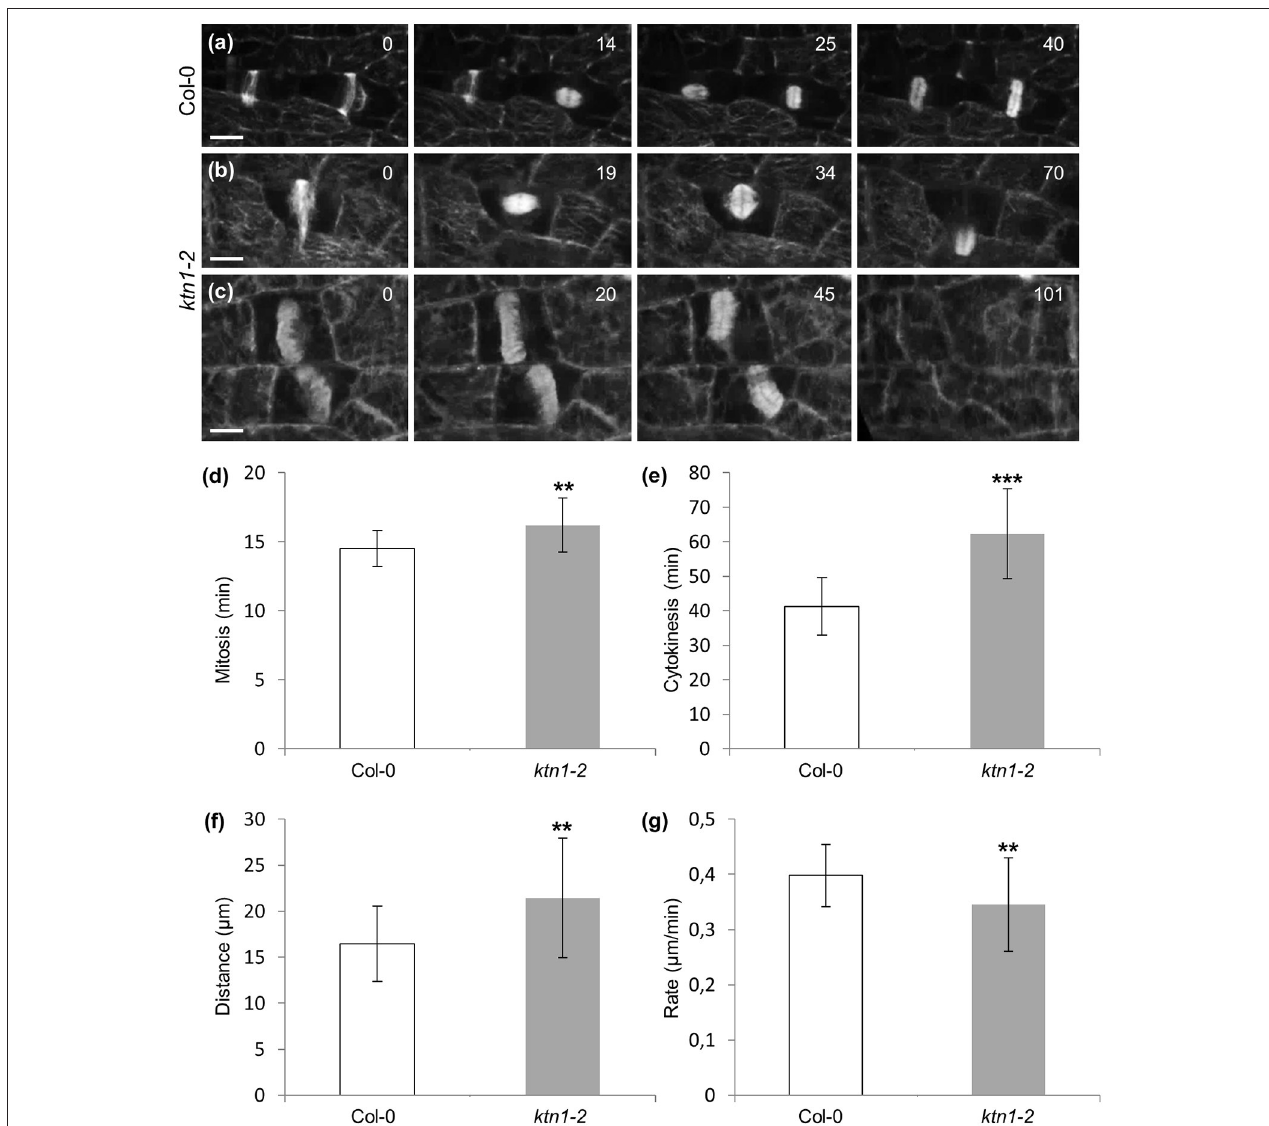
FIGURE 9 | Mitotic and cytokinetic progression in Col-0 and ktn1-2 petiole epidermal cells expressing a GFP-TUA6 microtubule marker, after spinning disc 3D time-lapsed imaging. (a) Transition from PPB to spindle and finally to phragmoplast formation and expansion in two dividing Col-0 petiole epidermal cells. Corresponds to Video S8 . (b) Microtubule reorganization from PPB to spindle and to phragmoplast in a dividing ktn1-2 petiole epidermal cell showing significant delay in phragmoplast expansion. Corresponds to Video S6 (showing continuation of mitotic progress in cell shown in Figure 7b ). (c) Delayed phragmoplast expansion and bending in ktn1-2 . Corresponds to Video S9 . (d–g) Quantitative evaluation of mitotic progression comparing Col-0 and ktn1-2 , showing duration of mitosis with significant delay of ktn1-2 ( d ; ** p < 0.01; N = 20 for Col-0 and N = 45 for ktn1-2 ), cytokinesis ( e ; *** p < 0.001; N = 20 for Col-0 and N = 45 for ktn1-2 ), distance covered during expansion of phragmoplast ( f ; ** p < 0.01; N = 20 for Col-0 and N = 45 for ktn1-2 ) and rate of phragmoplast expansion ( g ; ** p < 0.01; N = 20 for Col-0 and N = 45 for ktn1-2 ). Scale Bars: (a–c) 10 µ m, (h–j) 5 µ m. Numbers in (a,b) correspond to time (min). Time required for an entire Z-stack was 8.6s for (a) , 7.1s for (b) , and 8.3s for (c)